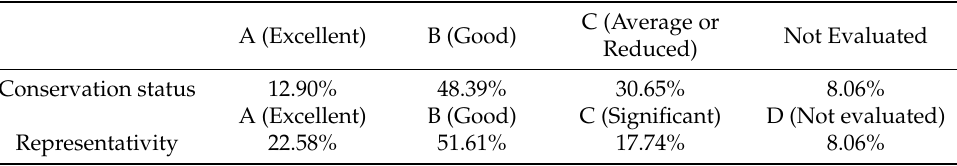
Table 3. Conservation status and representativity of the habitat types of Greek Natura 2000 sites invaded by Solanum elaeagnifolium